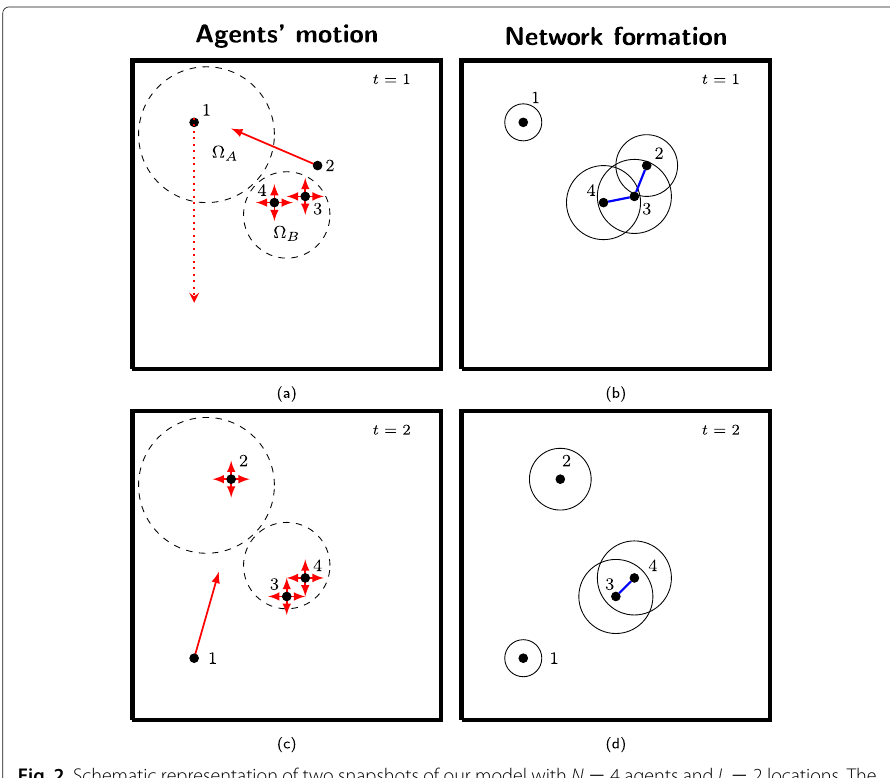
Fig. 2 Schematic representation of two snapshots of our model with N = 4 agents and L = 2 locations. The entire space is delimited with solid black lines. In a and c , we illustrate the agents’ motion and the border of the locations is represented with dashed black lines. Agents 1 and 2 are assigned to location A : = β( 1 ) = β( 2 ) , while agents 3 and 4 are assigned to location B : = β( 3 ) = β( 4 ) . Direction and modulus of the agents’ velocity is drawn with solid red arrows. The position where agent 1 will jump is indicated with a dotted red arrow. The four arrows around an agent indicate that it will move in a random position inside its own location. In b and d , we show the temporal network formation mechanism. Agents’ radii of interaction are represented with solid circles, and undirected links are represented with solid blue